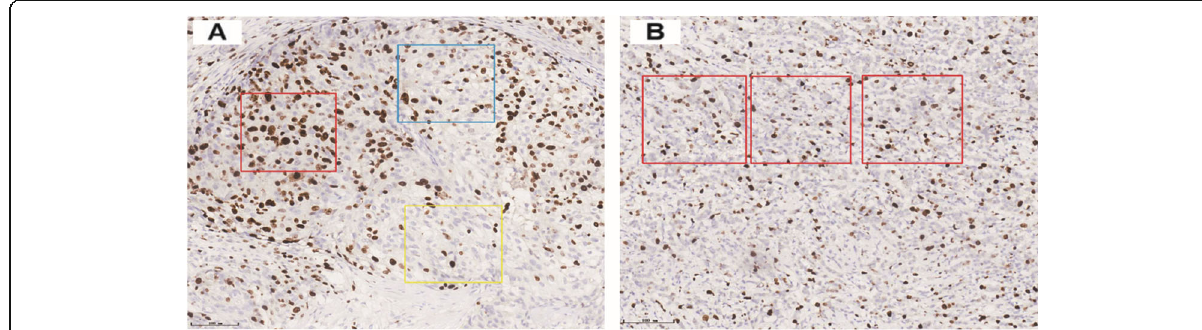
Fig. 2 Artificial intelligence software reading frame. A: In heterogeneous tumors,200 × 200 μ m reading frame (20×), Red frame covers the hot spot area; Yellow frame covers the cold spot area; Blue frame covers the middle value-added area;B: In homogeneous tumor, 200 × 200 μ m reading frame (20×)